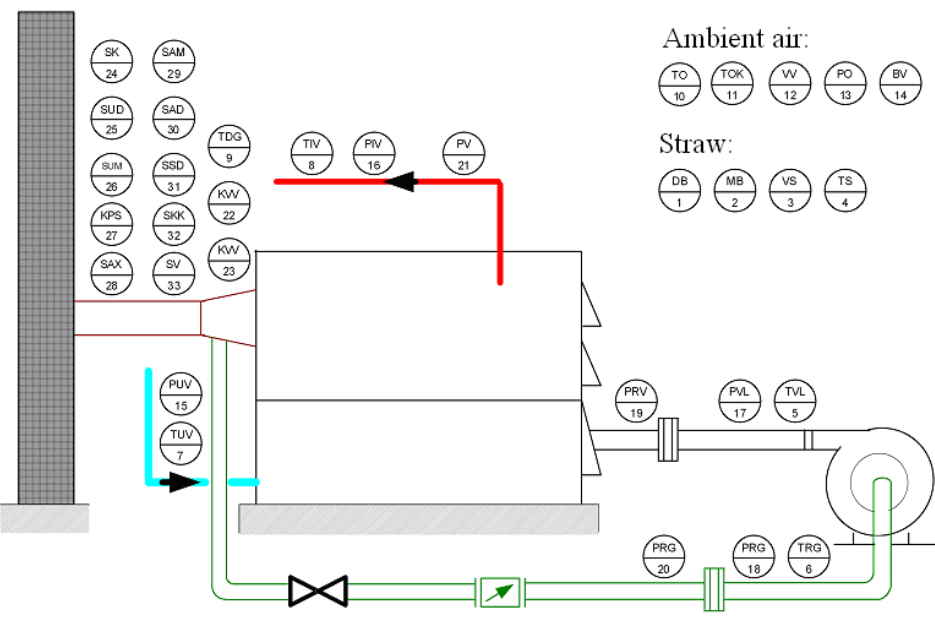
Figure 2. Layout of measurement points.